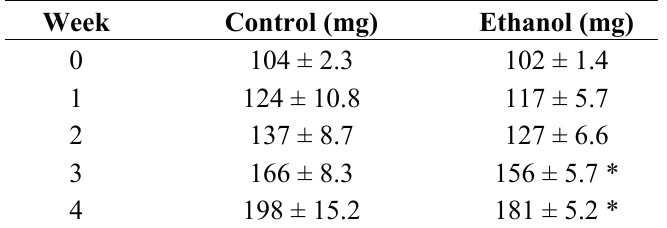
Table 1. Body weight changes after chronic ethanol consumption for four weeks. Week